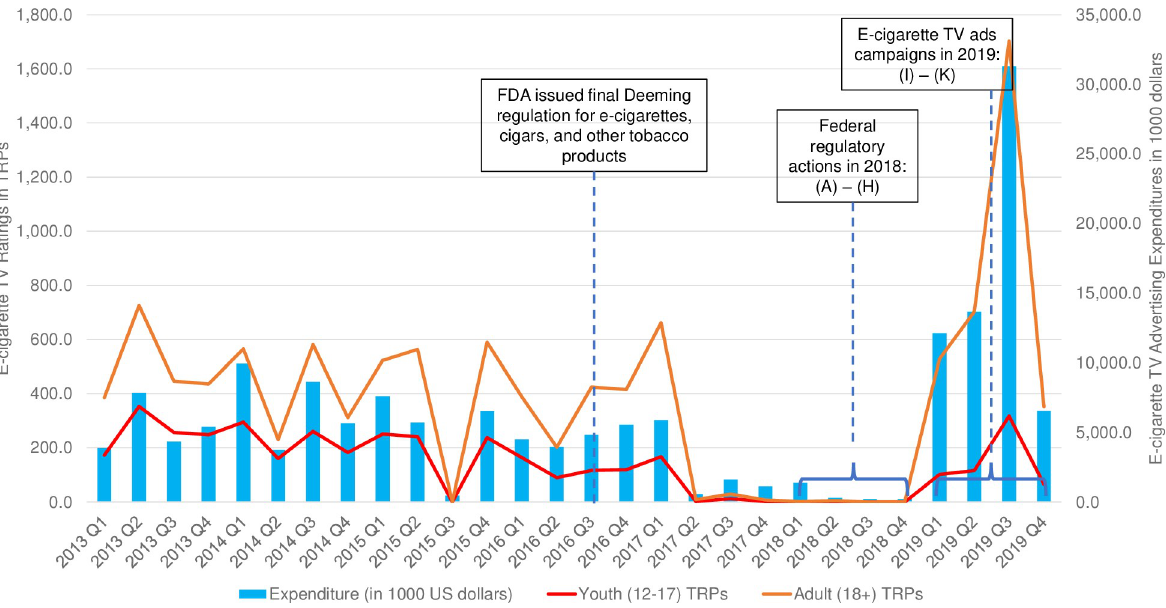
Fig 1. Quarterly e-cigarette TV advertising expenditures and TV target rating points (TRPs) among U.S. youth and adults, 2013–2019. (A) February 24, 2018, FDA sent a letter to JUUL expressing concerns about the popularity of JUUL products among youth and requested